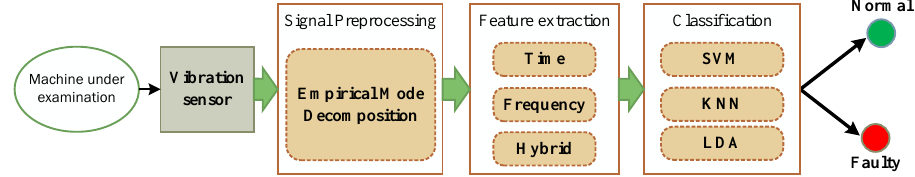
Figure 1. Pipeline of proposed machine fault detection approach.